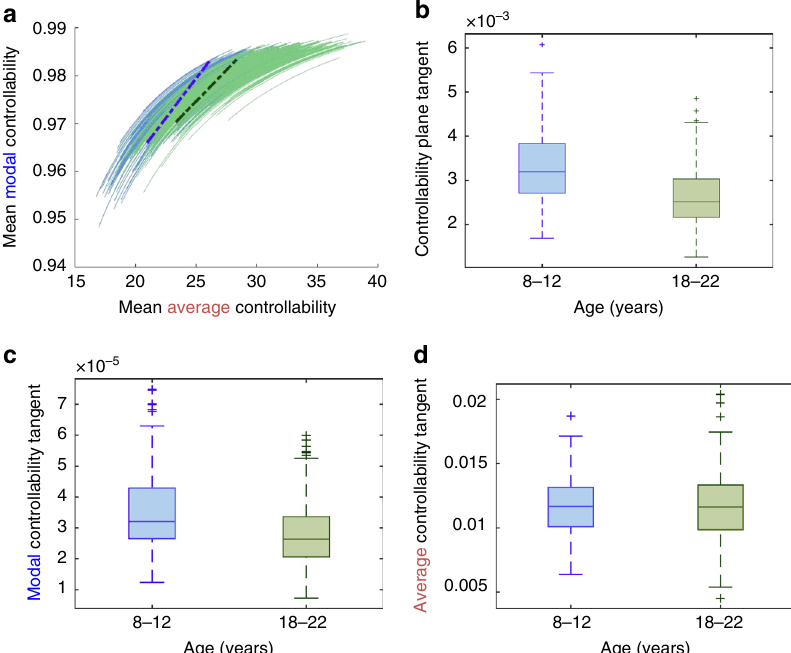
Fig. 7 Steeper trajectories in children vs. youth ages 18 – 22. a We compare two cohorts of different ages, 170 children from ages 8 – 12 years (blue), and 190 youth from ages 18 to 22 years (green). Based on their forward Pareto-optimization trajectories, we fi t exponential curves y = a + b exp ( cx ) for each subject, where x is the mean average controllability and y is the mean modal controllability, to obtain the curve tangent at the position of the brain network. The mean tangents of both groups are shown as dotted lines: the children ’ s in blue and the older youth ’ s in green. b The distribution of tangents for both groups shows that children have a 27% steeper slope in their optimization curves as compared to the youth ages 18 – 22; non-parametric permutation test p < 0.001. c This difference arises from the evolutionary curve in modal controllability, as can be seen by a separate examination of how modal controllability changes with each rewiring step (group difference in tangent: p < 0.001) — suggesting that children have a greater potential for increasing their ability to make distant or dif fi cult changes in mental state than older youth. d In contrast, there is little group difference in the change of average controllability with each rewiring step ( p = 0.47), suggesting that the potential to increase nearby mental switches remains constant over